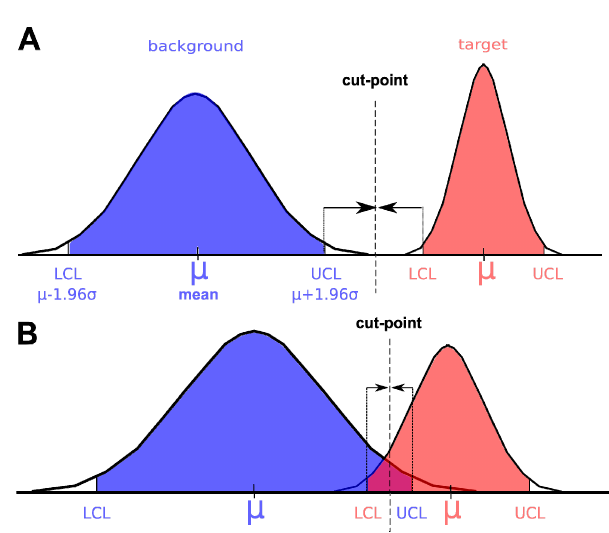
Figure 4. Graphical example on how a new cut-point is estimated from rule-image values extracted with training polygons. The lower confidence limit (LCL = µ − 1.96 σ ) and upper confidence limit (UCL = µ + 1.96 σ ) of the background and target distributions are estimated. The new cut-point is (UCL background + LCL target )/2, provided that target µ > background µ. ( A ) represent a the situation when distributions do not overlap; and ( B ) a situation when they overlap.